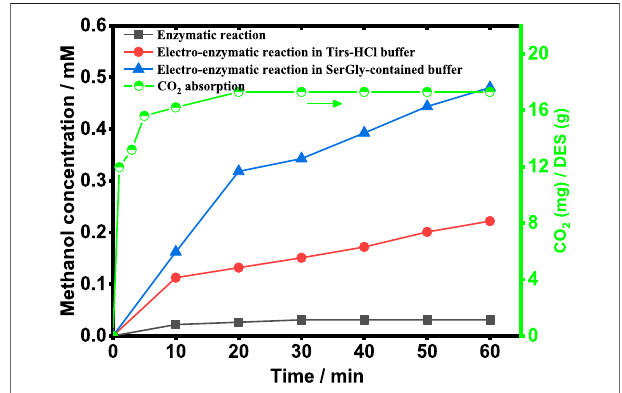
FIGURE 5 | Electro-enzymatic reaction for methanol production under different conditions and the CO 2 concentration in the SerGly-contained